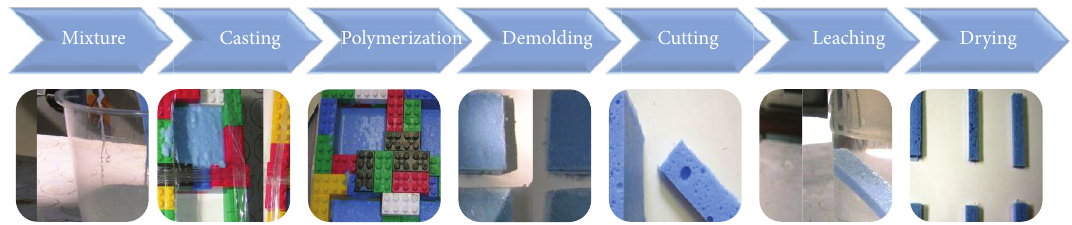
Figure 2: Overview of the manufacturing process used for obtaining PDMS sponges.